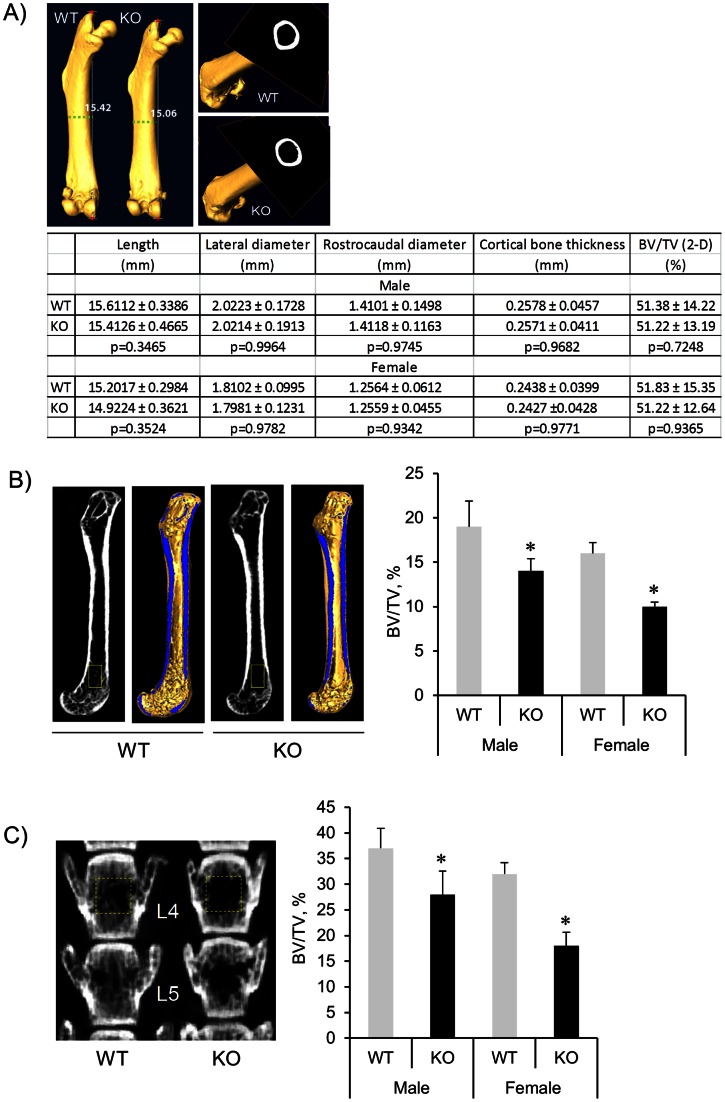
Trabecular bone volume is reduced in Pin1 KO mice.3D µCT reconstruction and slice of representative femurs and vertebral sections from 4 month-old mice. (A) Femoral bone parameters were determined with 3D construction using Amira and ImageJ softwares. Upper right: Cross-sectional slice at mid-diaphysis from each femur. (B and C) Trabecular bone volume (BV/TV) of the distal end of femurs (B) and the lumbar vertebra (L4) (C) was quantified as described in the Methods after slicing the 3D construction in longitude direction. *denotes p<0.05 by paired student t-test with 8 mice per group.